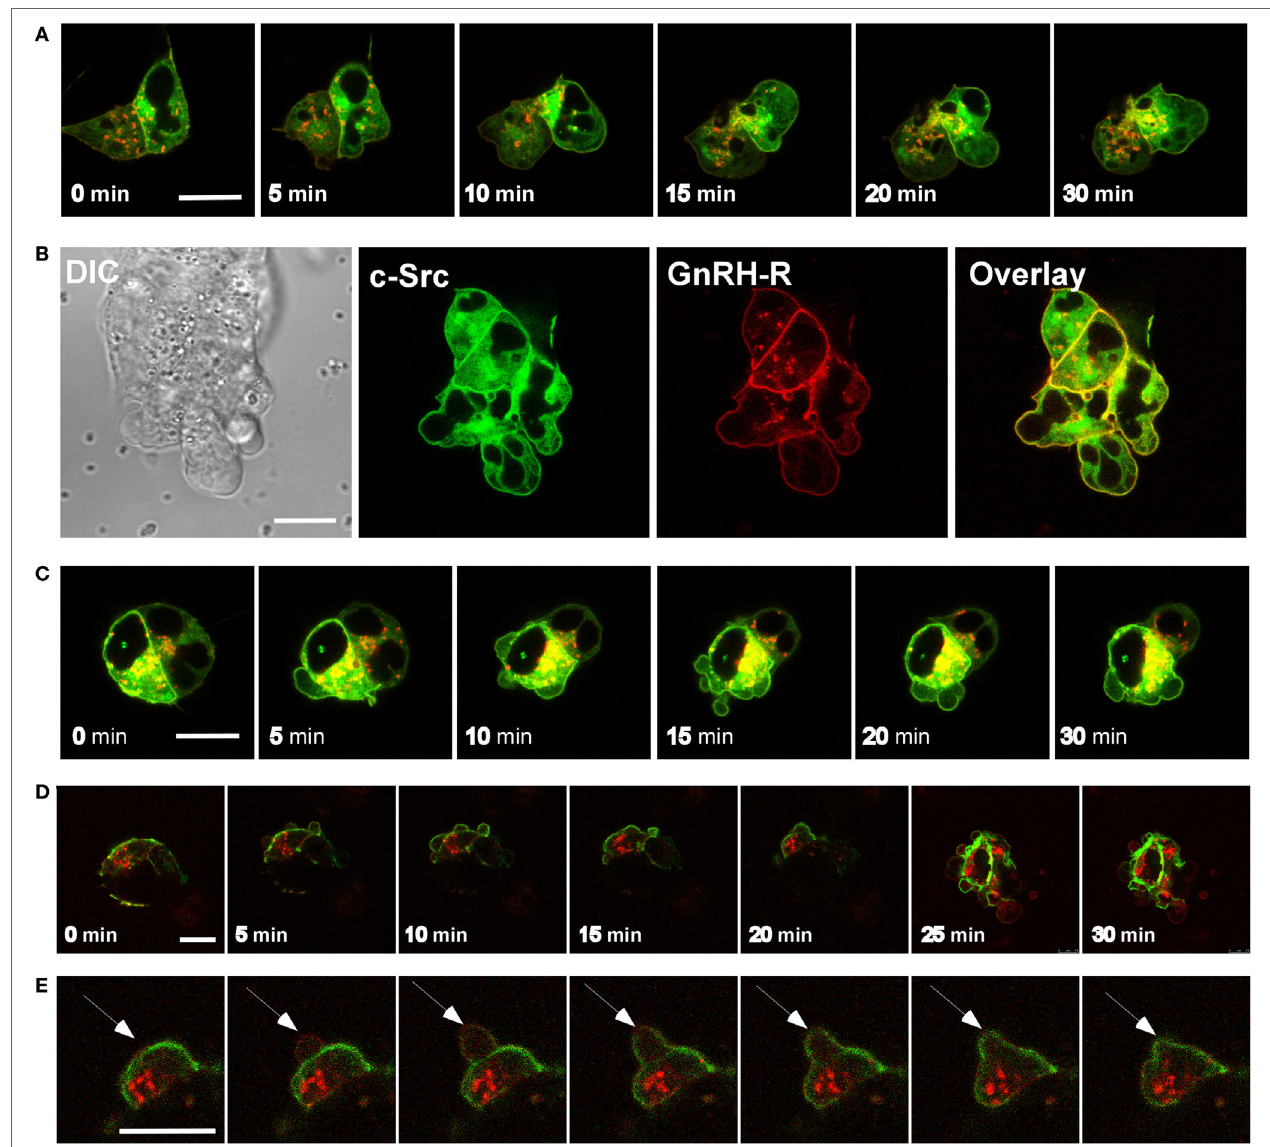
FigUre 5 | c-src and vinculin are present in the blebs . (a) Addition of GnRH (0–30 min, 10 nM) to serum-starved L β T2 cells transfected with c-Src-GFP and GnRH receptor (GnRHR)-mCherry resulted in bleb formation, while c-Src is present in the blebs. The scale bar is 10 µm. (B) Blebs time laps of DIC and fluorescent images of Src-GFP, GnRHR-mCherry, and overlay showing colocalization of c-Src and the GnRHR in the blebs. The scale bar is 10 µm. (c) Serum-starved L β T2 cells transfected with c-Src-GFP and GnRHR-mCherry were pretreated with the c-Src inhibitor PP2 (10 µM) for 30 min. Thereafter, GnRH (10 nM) was added for 30 min. Similar results were observed in two other experiments. The scale bar is 10 µm. (D) Addition of GnRH (0–30 min, 10 nM) to serum-starved L β T2 cells transfected with GnRHR-mCherry and vinculin-GFP resulted in bleb formation, while vinculin is present in the blebs. The scale bar is 10 µm. (e) Unlike c-Src, ERK1/2, focal adhesion kinase, and paxillin (see below), vinculin was recruited to the blebs during stabilization and retraction. Addition of GnRH (10 nM) to serum-starved L β T2 cells transfected with GnRHR-mCherry and vinculin-GFP resulted in bleb formation, single blebs were monitored every 10 seconds. The scale bar is 10